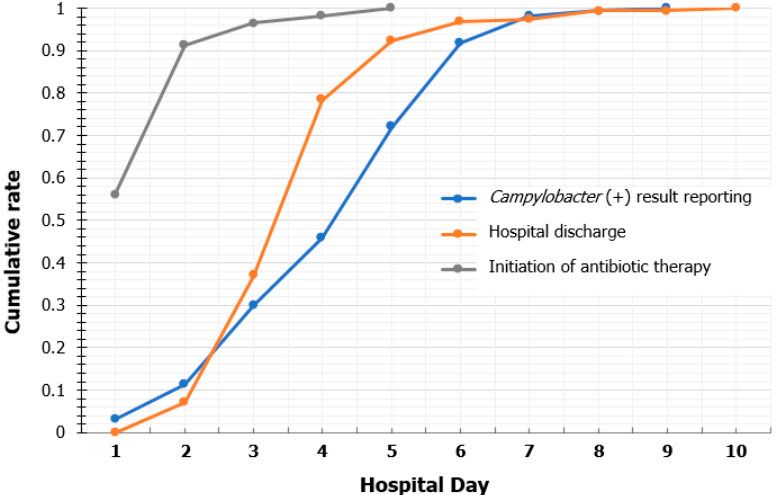
Figure 1. Cumulative rate of Campylobacter enterocolitis confirmations, discharge, and the initiation of antibiotic therapy according to hospital day.